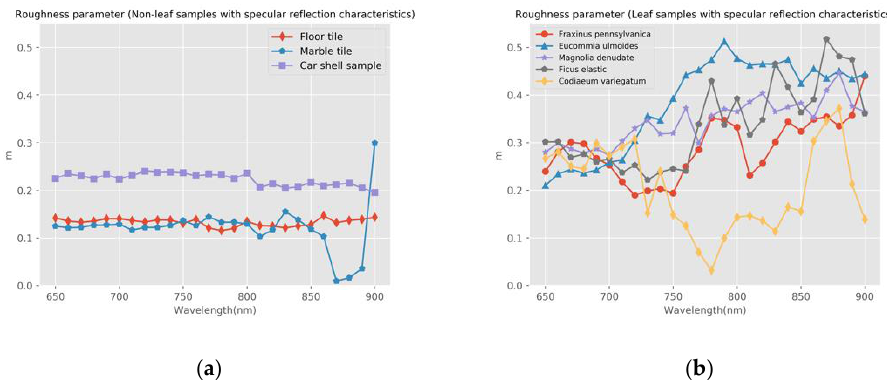
Figure 7. The relationship between diffuse reflection coefficient, k d , and wavelength, 𝜆 . ( a ) Non- leaf samples; ( b ) Leaf samples.